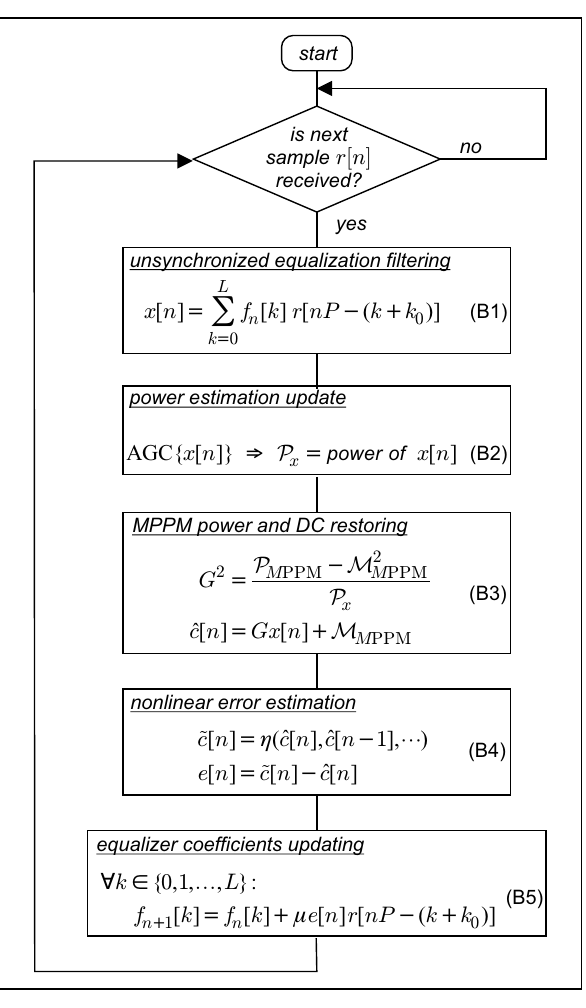
Figure 5. LMS blind Bussgang FSE